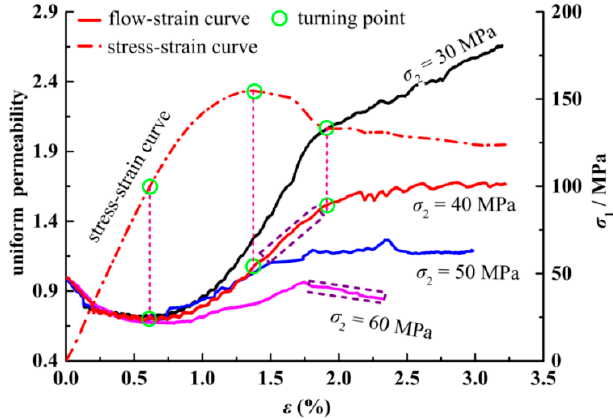
Figure 8. Relationship between permeability, σ 1 , and ε 1 .